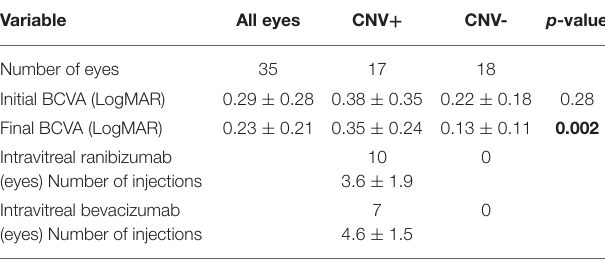
TABLE 2 | Characteristics of eyes with PIC included in the study.